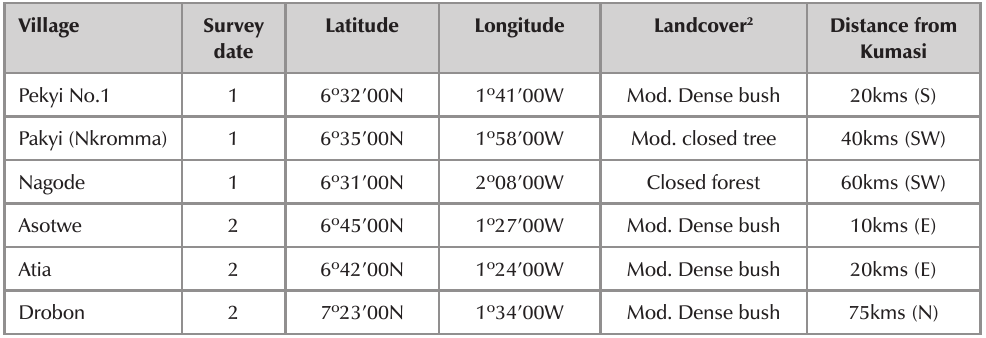
Village location and characteristics (1 = August 2002; 2 = July